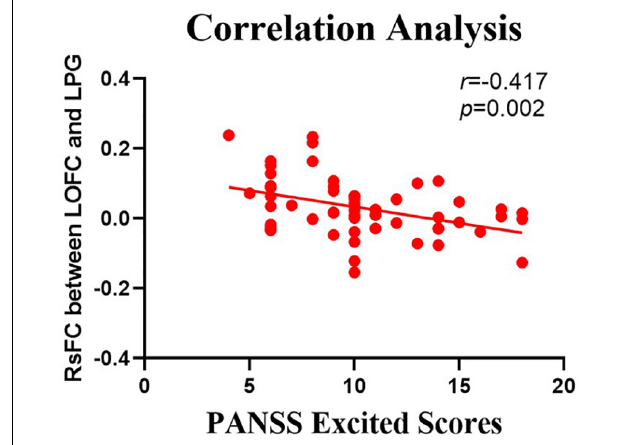
FIGURE 5 | Negative correlation between the resting-state functional connectivity (rsFC) values and the severity of exited scores in the FES. The X-axis is the score of the excited factors of the PANSS scale, and the Y-axis shows the functional connectivity of the left orbitofrontal cortex (LOFC) and left postcentral gyrus (after correcting for positive symptoms, age, gender, education, and illness duration).